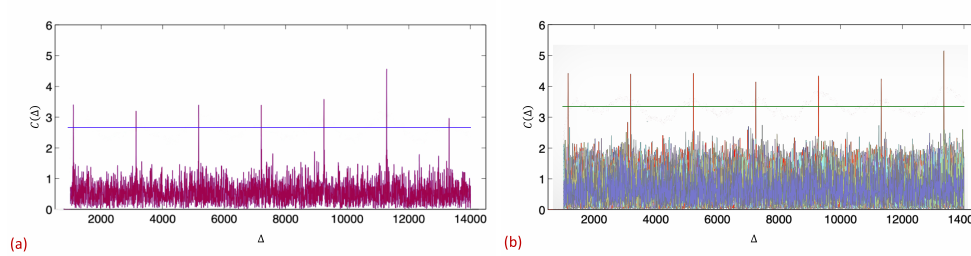
Figure 4. A sender conveys information to the receiver via a pre-defined CSS. For each newly acquired sample, y ( k + ∆ ) , the receiver computes the signal’s correlation with a local copy of a s ∗ ( k ) y ( k + ∆ ) , where s ∗ denotes the complex conjugate of the target particular CSS, C ( ∆ ) = ∑ L − 1 k = 0 CSS: s . The correlation value spikes every time a pre-defined CSS is received. ( a ) Signal correlation of seven repetitions of a 127-symbol-length Gold-code codeword under background interference, generated by random OFDM transmissions of a potential background interference (received signal to interference and noise ratio (SINR) is − 6 dB). ( b ) Cross-correlation values of a specific CSS when an additional 10 different CSSs were sent. The figure depicts the cross-correlation values with each of the 11 CSSs. The correlator spikes when the designated CSS is received. It is low for all ten other CSSs. Note that the cross-correlation values stay low until y ( ∆ ) is aligned with the beginning of s